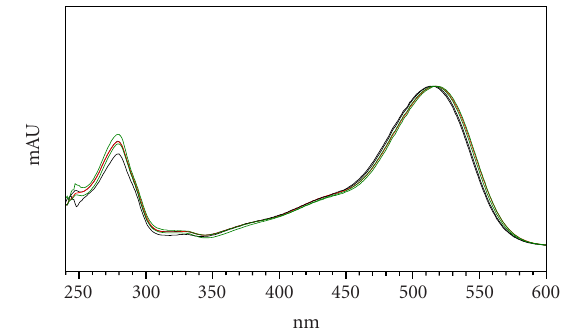
Figure 4. Overlapped spectra of cyanidin 3-glucoside chlo- ride standard with the spectra of peaks eluting at times 10 . 133; 11 . 300; 12 . 200; 13 . 133; 13 . 967